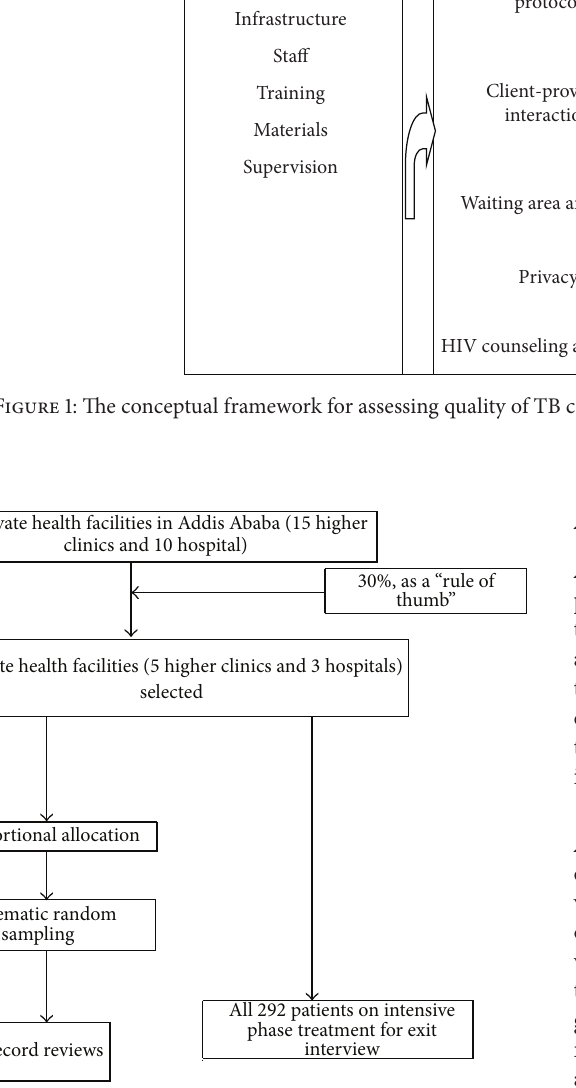
Figure 2: Schematic presentation of selection of health facilities and sampling strategies in private health facilities of A. A,